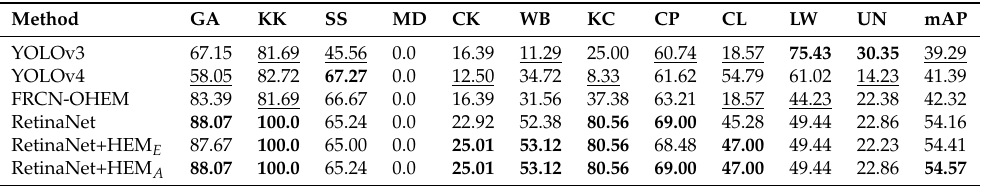
Table 4. The results of detection AP for each category in HEM experiments. The results with underline are the worst. and the results with bold are the